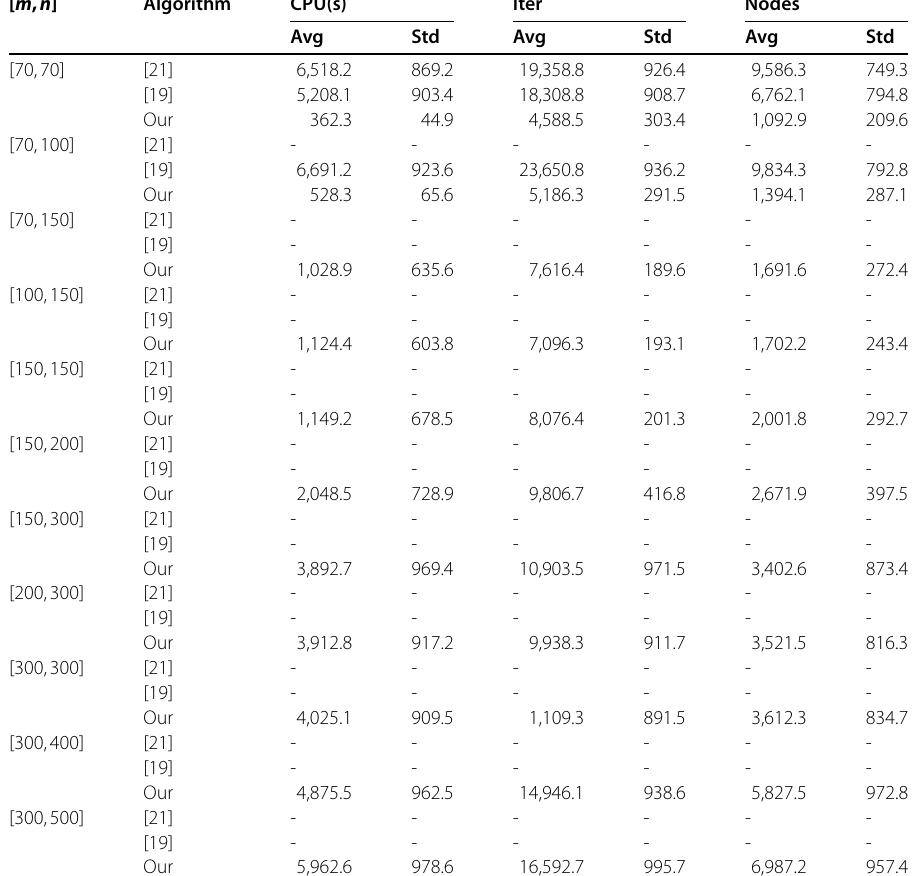
Table 3 Computational results of randomly generated test problems with p =